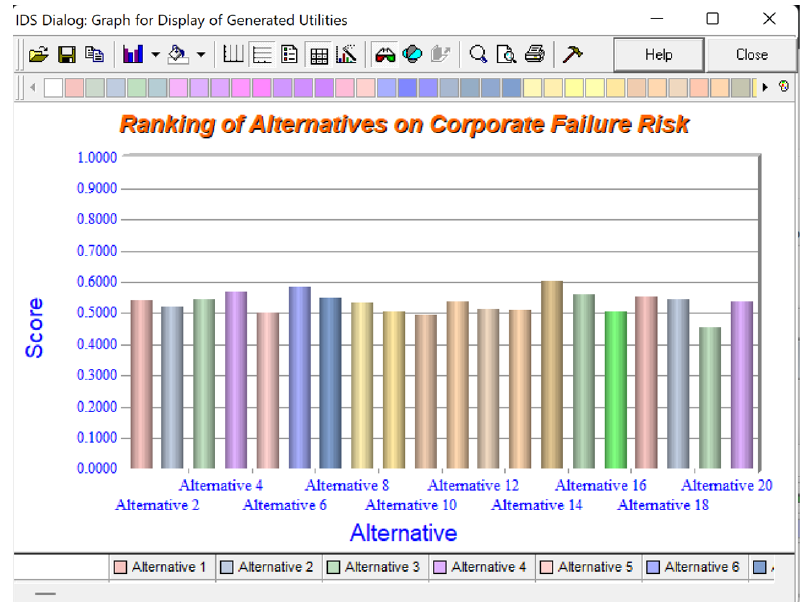
Figure 9. Risk ranking of the assessed firms.